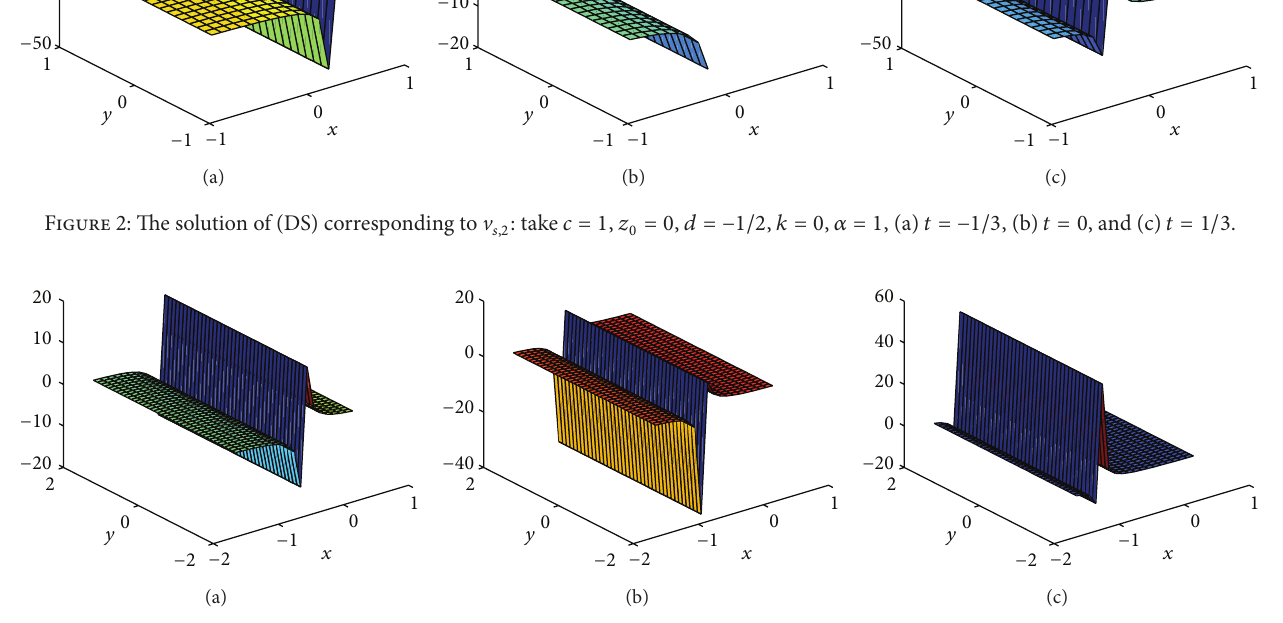
Figure 3: The solution of (DS) corresponding to V 𝑠,3 : take 𝑐 = 1 , 𝑧 0 = 0 , 𝑑 = 1/2 , 𝑘 = 0 , 𝛼 = 1 , (a) 𝑡 = −1/3 , (b) 𝑡 = 0 , and (c) 𝑡 = 1/3